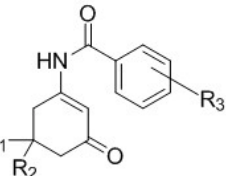
Figure 2. N-benzamide enaminone general structure. R 1 = CH 3 , R 2 = H or R 1 = R 2 = CH 3 ; R 3 = various aryl substitutions.